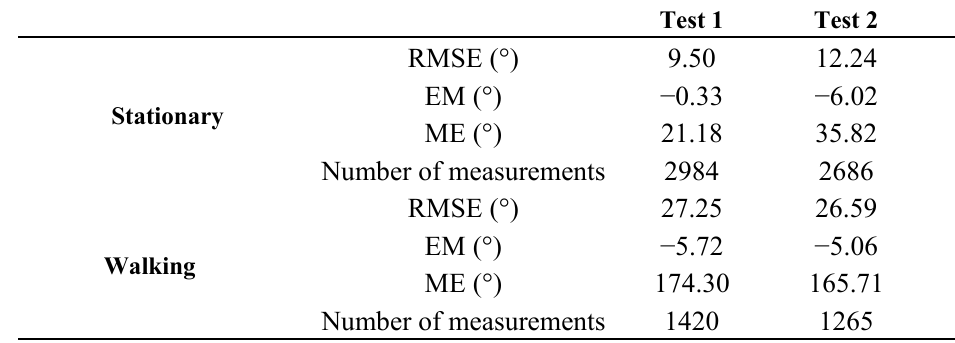
Table 2. The smartphone digital compass error statistics for stationary and walking